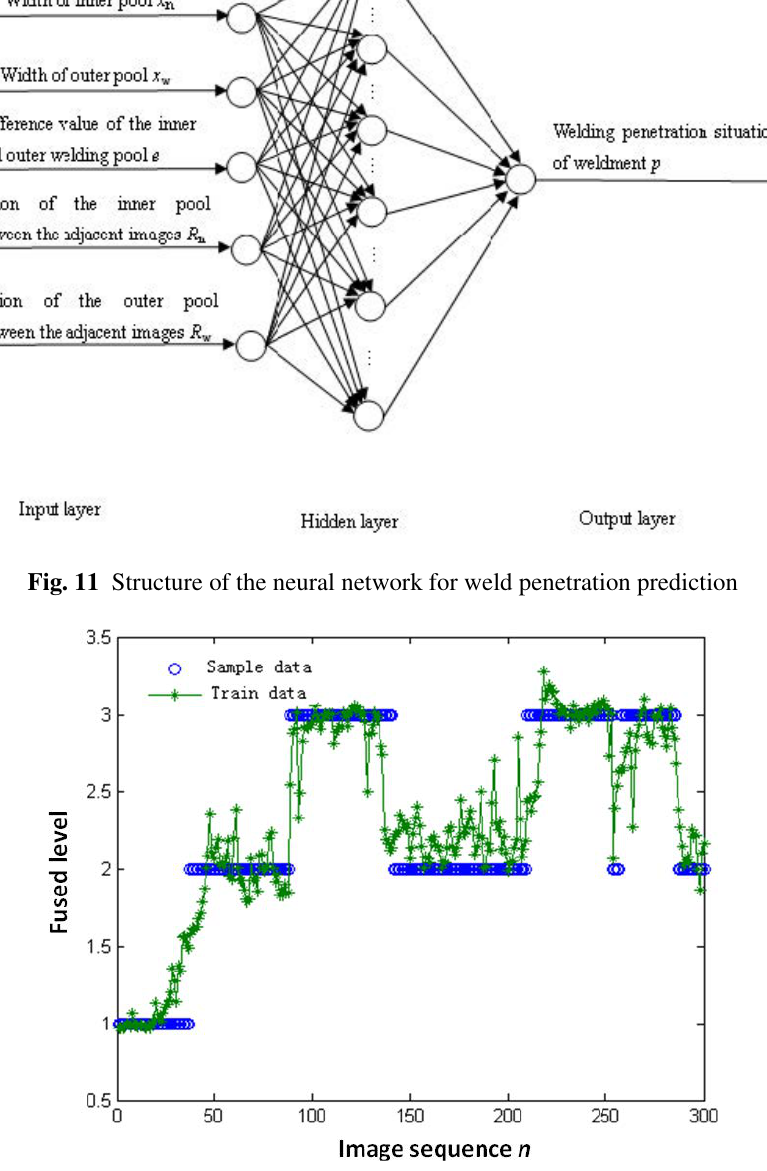
Fig. 12 Training